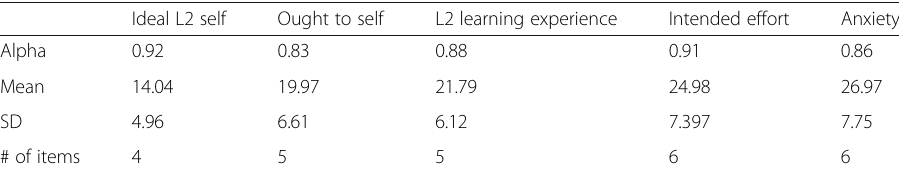
Table 1 Reliability of instruments ( N = 228) Ideal L2